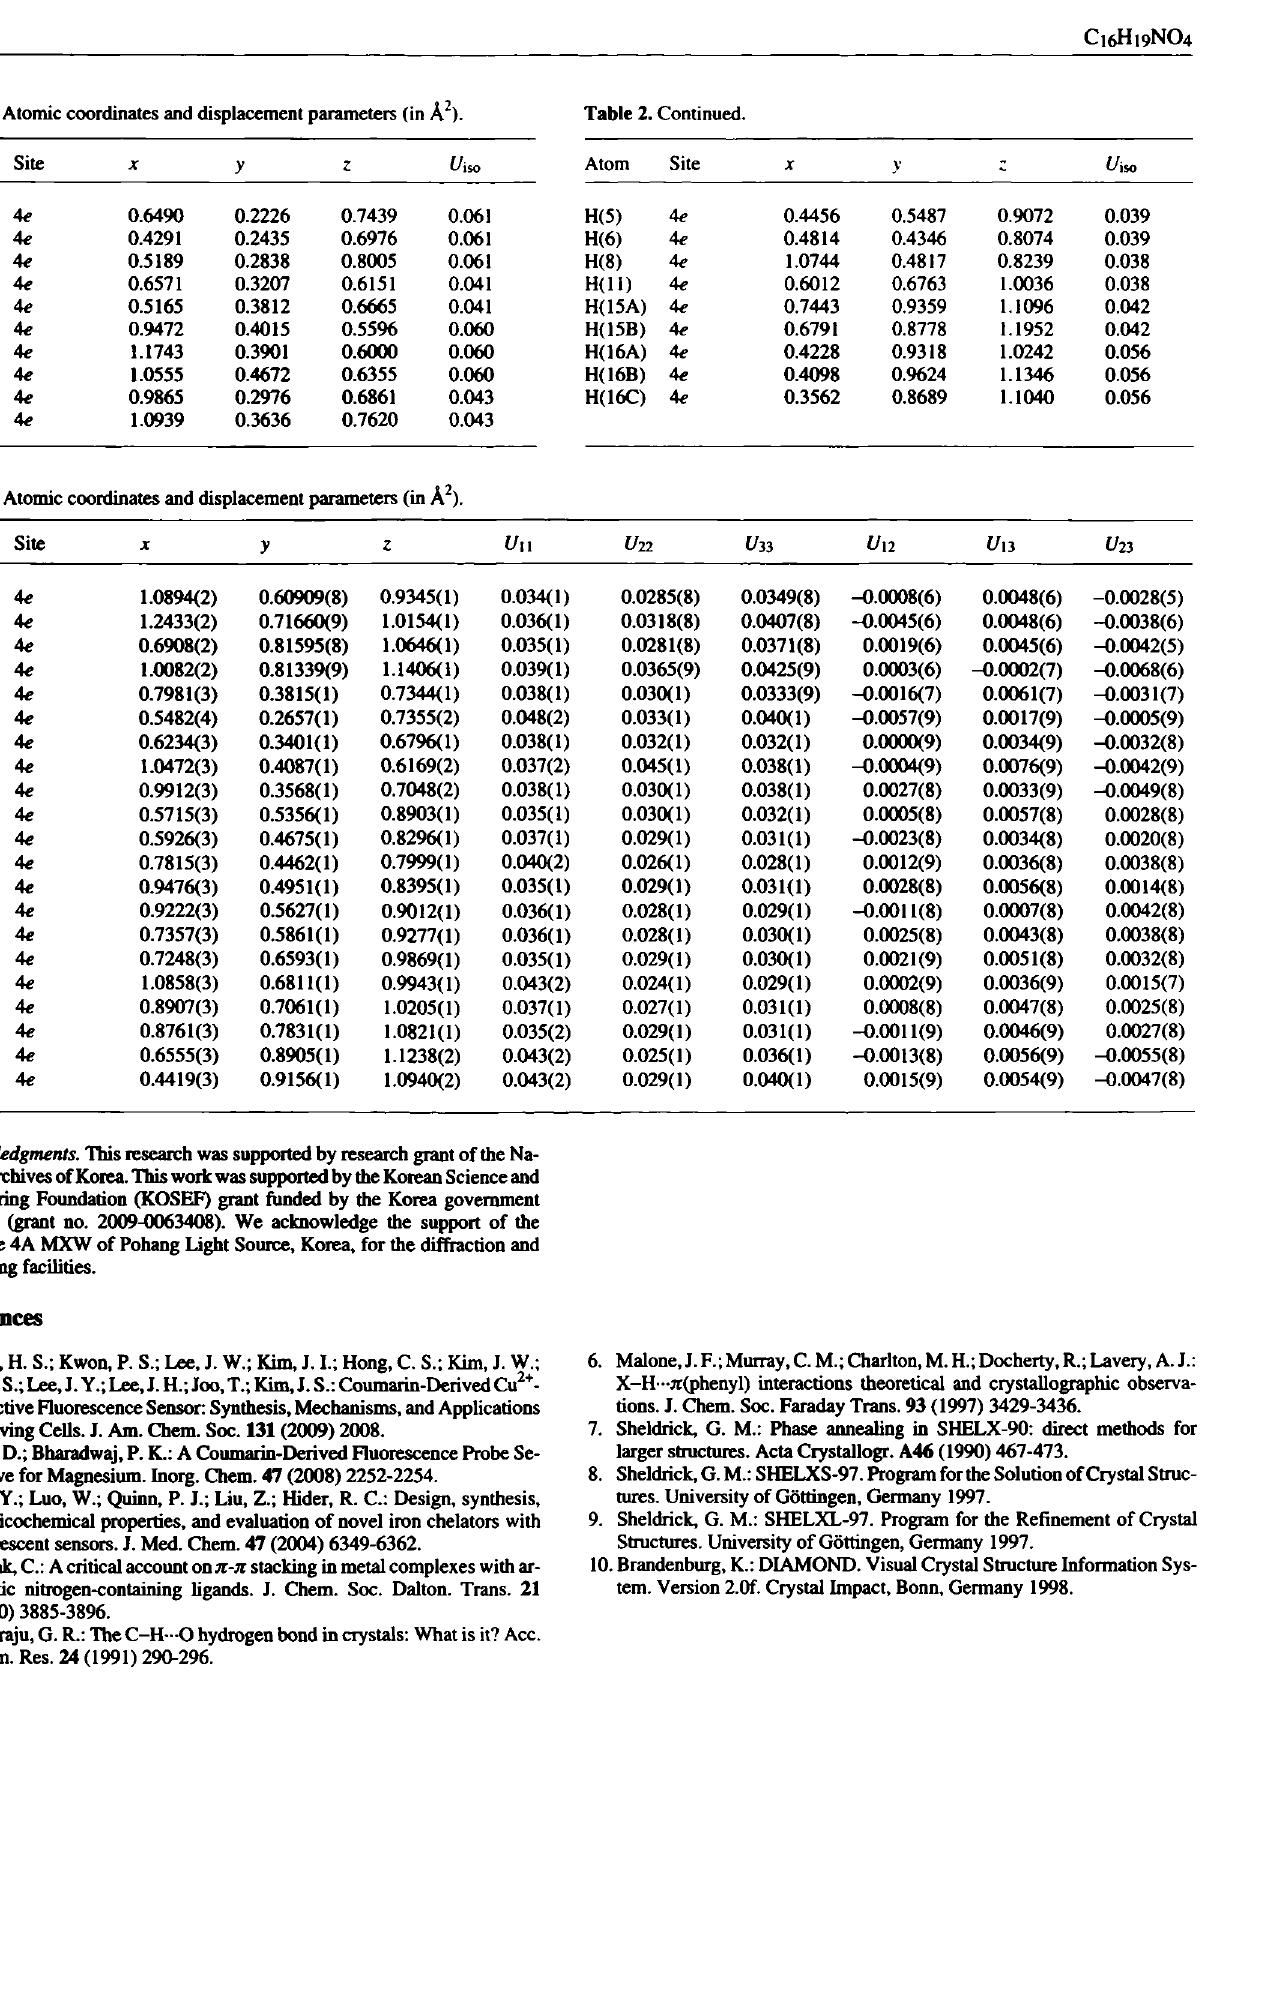
Table 2. Atomic coordinates and displacement parameters (in Â 2 ).